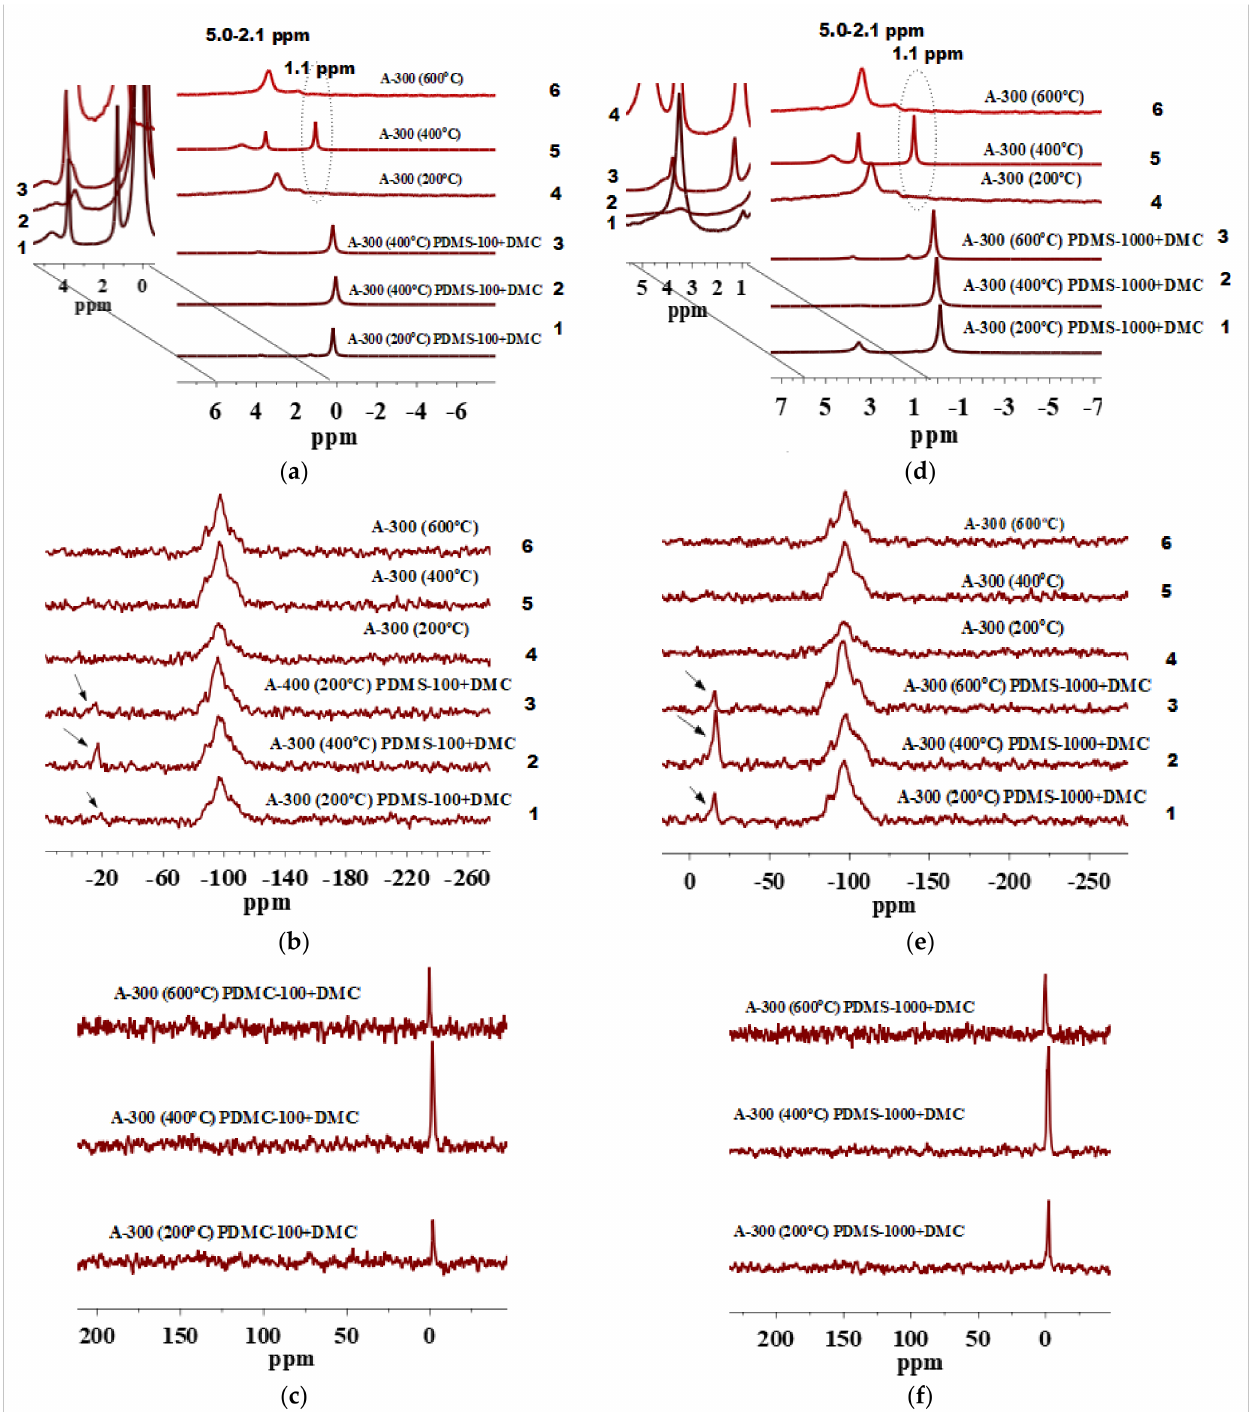
Figure 9. 1 H MAS NMR, 29 Si CP/MAS NMR, and 13 C CP/MAS NMR spectra of A-300 preheated at 200, 400, and 600 ◦ C and modified by ( a – c ) PDMS-100/DMC and ( d – f )